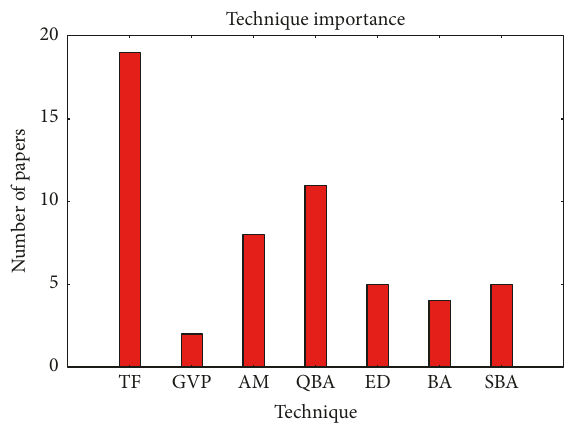
Figure 6: Number of papers by